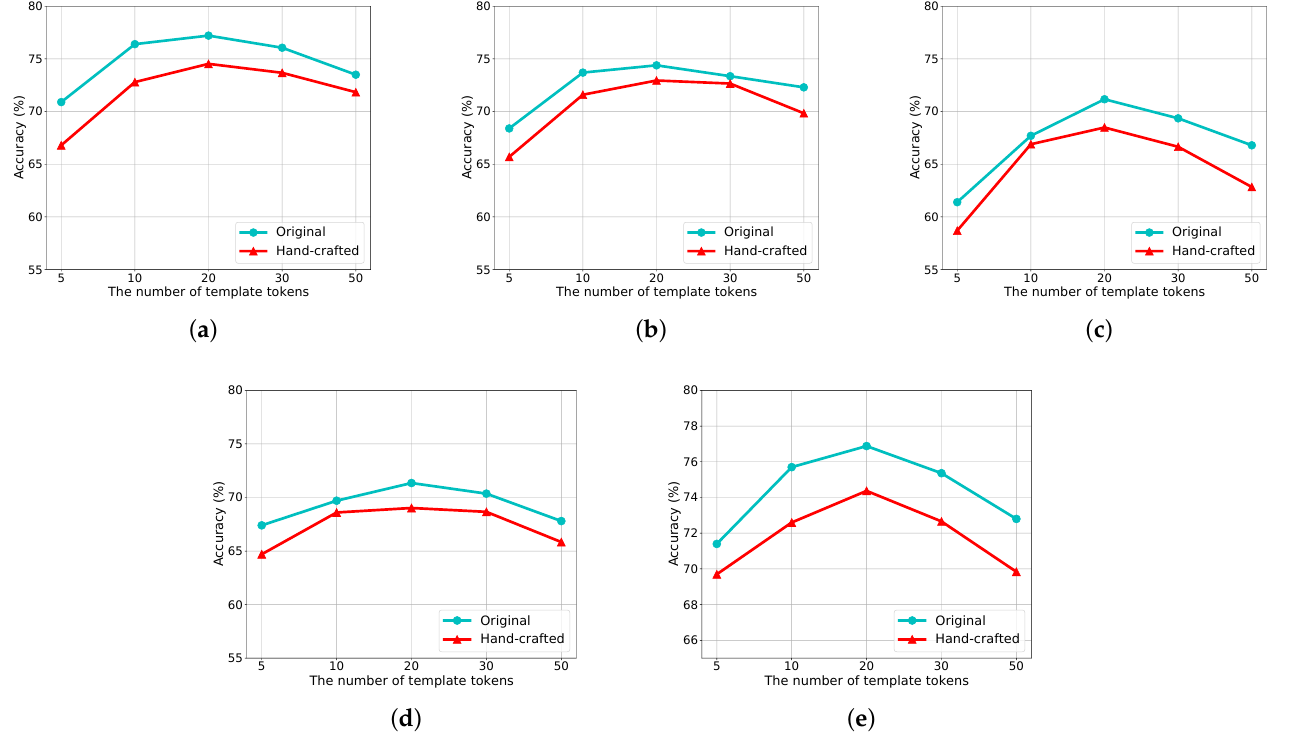
Figure 3. Model performance of TaxonPrompt and its variants with various language models on Few- Event. ( a ) Accuracy on AFQMC. ( b ) Accuracy on OCNLI. ( c ) Accuracy on TNEWS. ( d ) Accuracy on INEWS. ( e ) Accuracy on BQ dataset.